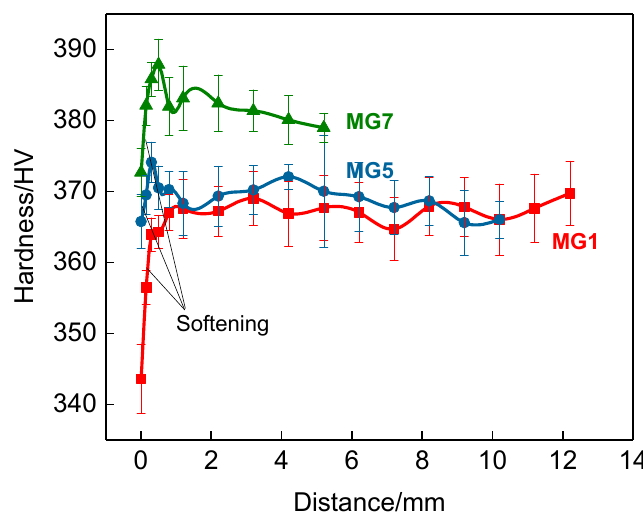
Figure 8. Hardness of MG1, MG5, and MG7.